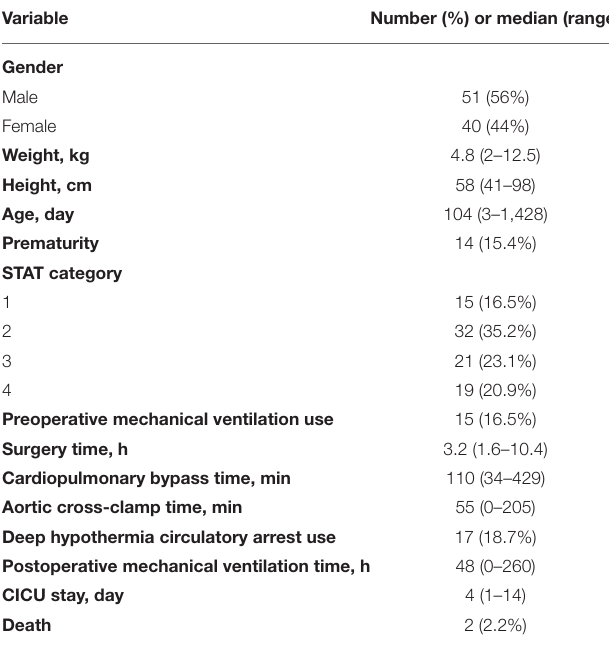
TABLE 1 | Demographic and clinical data in 91 children undergoing cardiopulmonary bypass surgery.